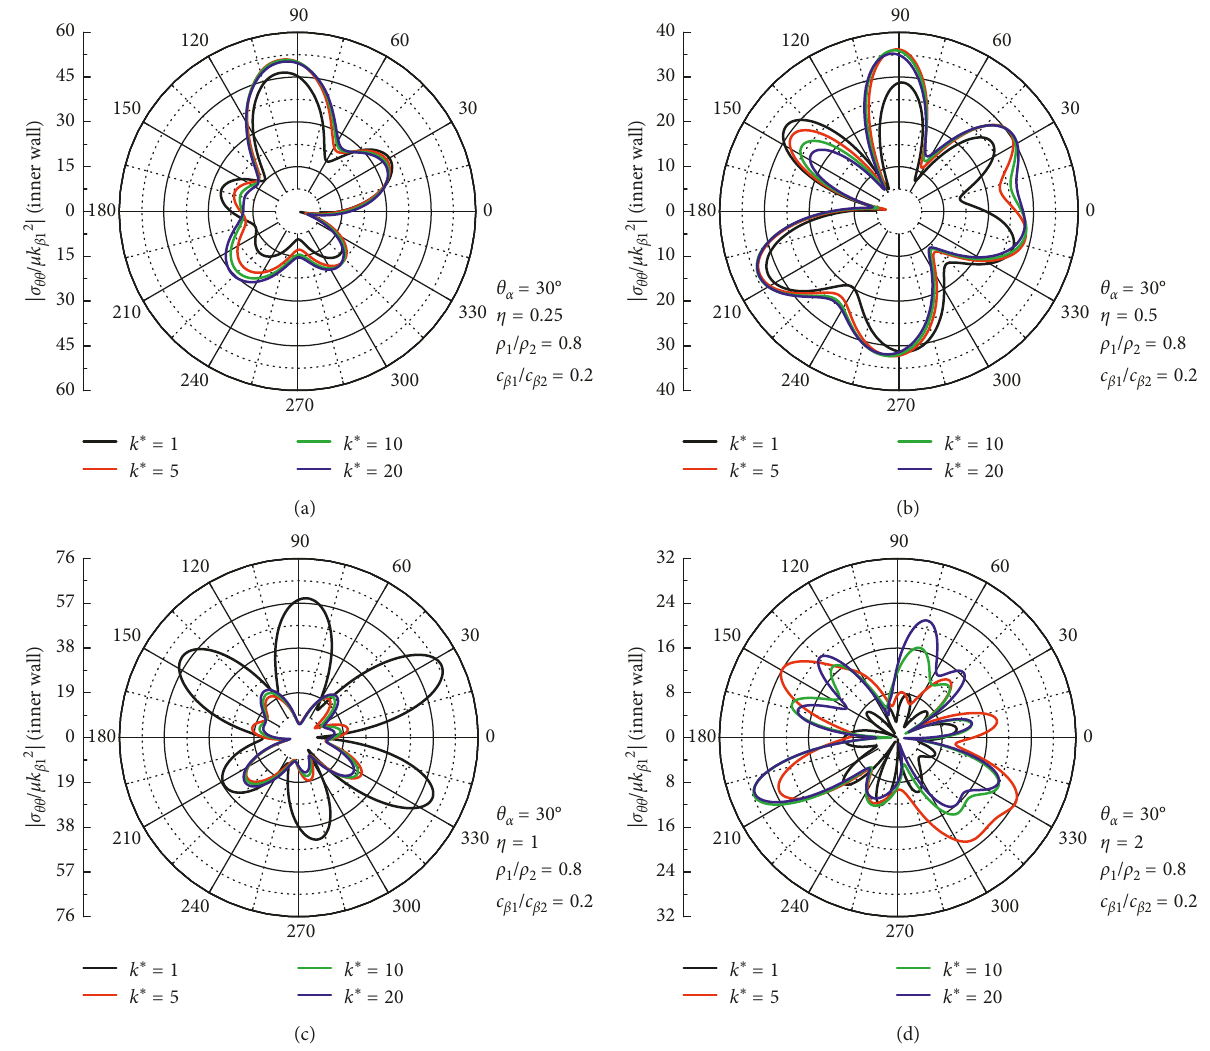
Figure 5: DSCF distribution on lining the inner wall under the incident SV wave ( θ